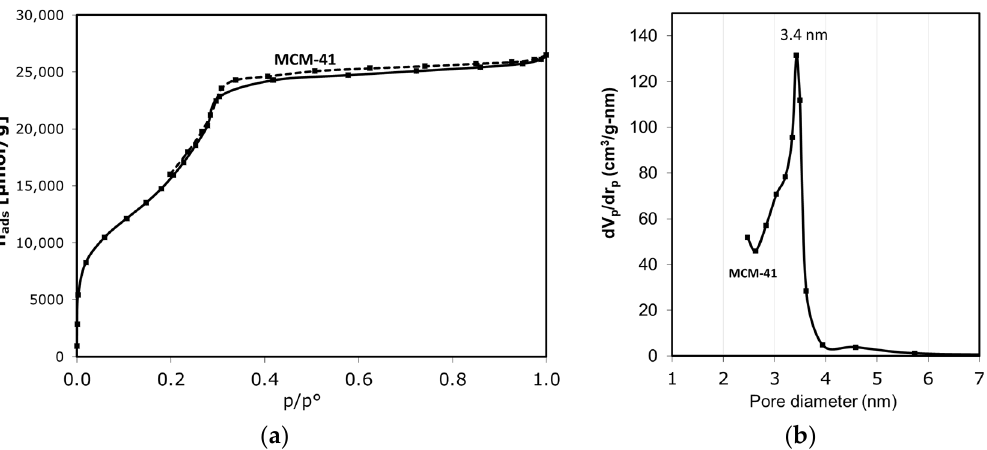
Figure 1. ( a ) Nitrogen adsorption–desorption isotherm at 77 K, and ( b ) BJH-KJS pore size distribution from desorption data, for MCM-41 catalyst. Table 1. Textural properties of MCM-41 catalyst, obtained by nitrogen adsorption–desorption.